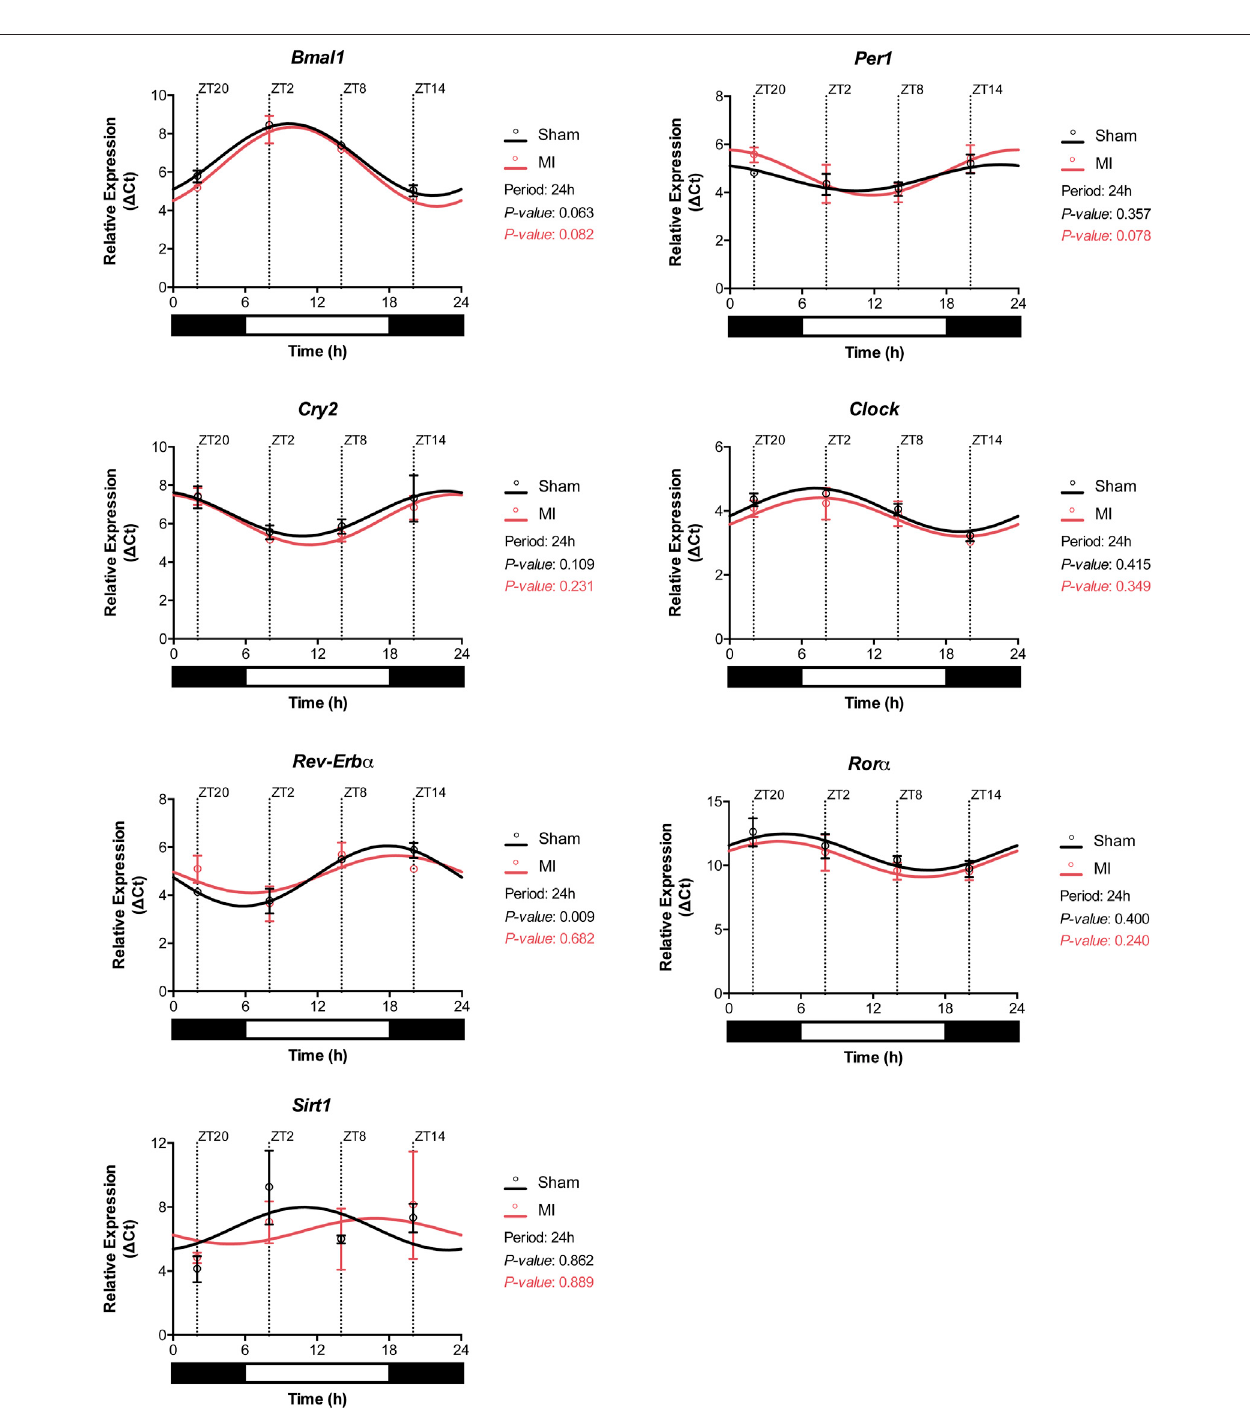
FIGURE6| Circadianclockgeneexpressionpro fi leintheheart.Expressionofthecircadianclockgenes Bmal1 , Per1 , Cry2 , Clock , Ror α , Rev-Erb α ,and Sirt1 inthe heart of sham- and MI-induced mice. ( n = 3 per group/timepoint for all analysis, ( *p < 0.05, **p < 0.01, and ***p < 0.001 , p -values determined by Cosinor analysis using the online platform: Cosinor. Online (https://cosinor.online/app/cosinor.php)).